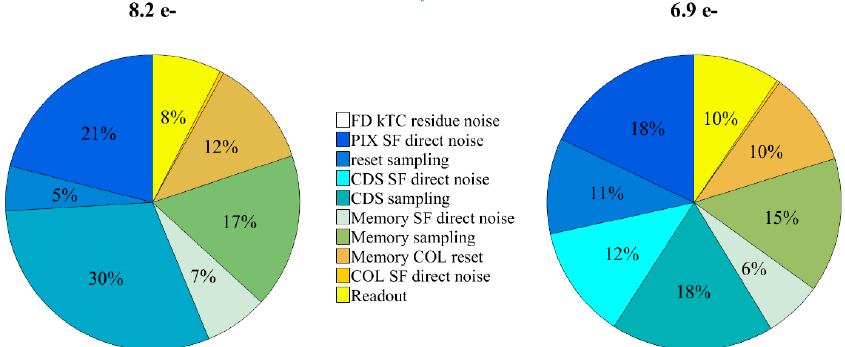
Figure 9. The input referred noise against sum of (cid:1829) (cid:2887)(cid:2888)(cid:2903) and (cid:1829) (cid:2903) w.r.t to different tracking time (15 ns settling time is targeted for 20 Mfps operation). Left : Type A. Right : Type B. The (cid:1829) (cid:2887)(cid:2888)(cid:2903) and (cid:1829) (cid:2903) are chosen according to the optimal ratio based on Equations (7) and (9).